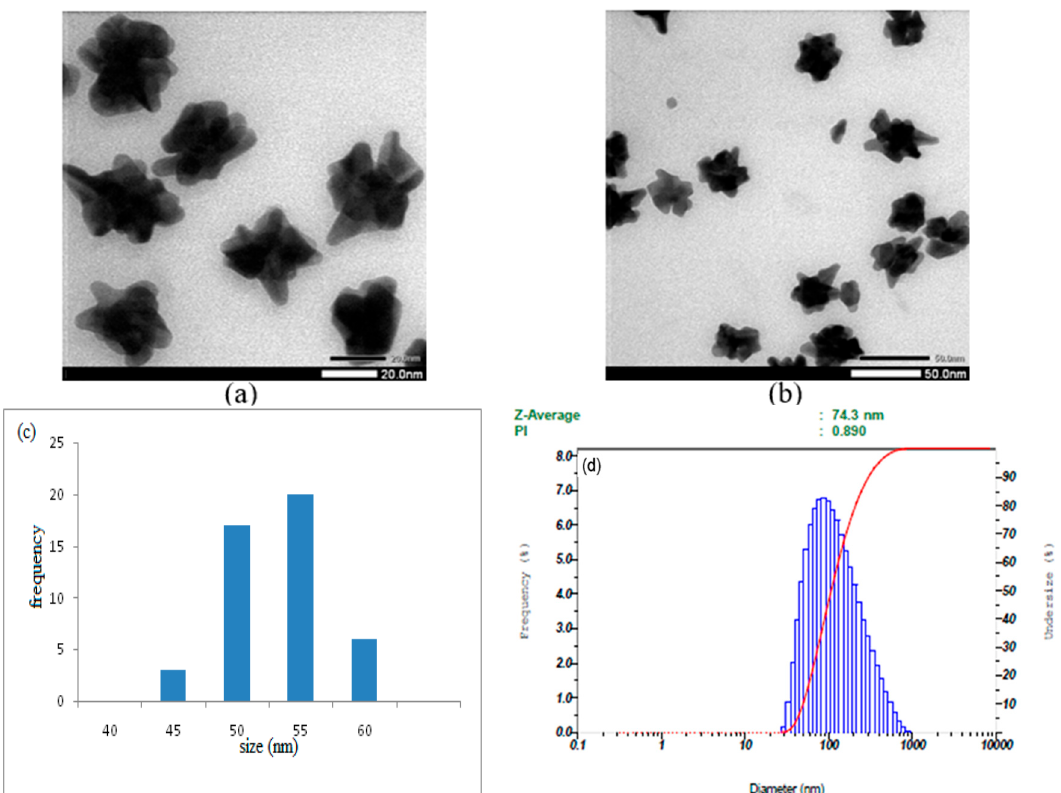
Figure 6. TEM images branched AuNPs ( a ) scale 20 nm; ( b ) scale 50 nm, ( c ) size distribution of branched gold nanoparticles (gelatin concentration 2.5%, w / v at pH 10.0) from TEM images and ( d ) size distribution of branched gold nanoparticles (gelatin concentration 2.5%, w / v at pH 10.0) from dynamic light scattering (DLS)